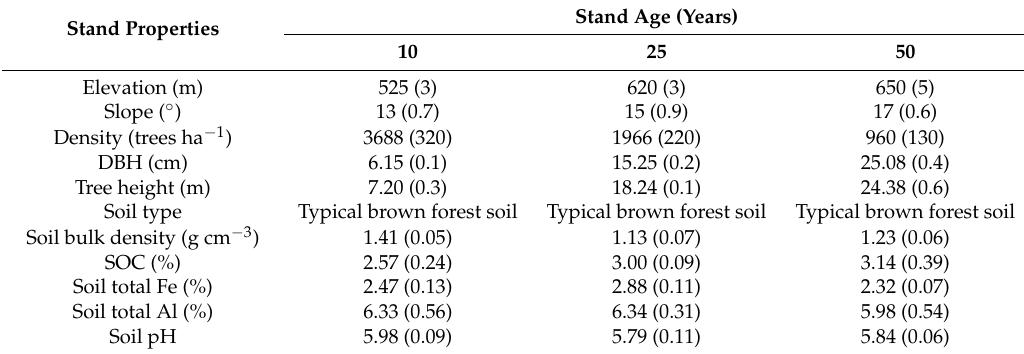
Table 1. Summary of stand properties of the three age classes of larch